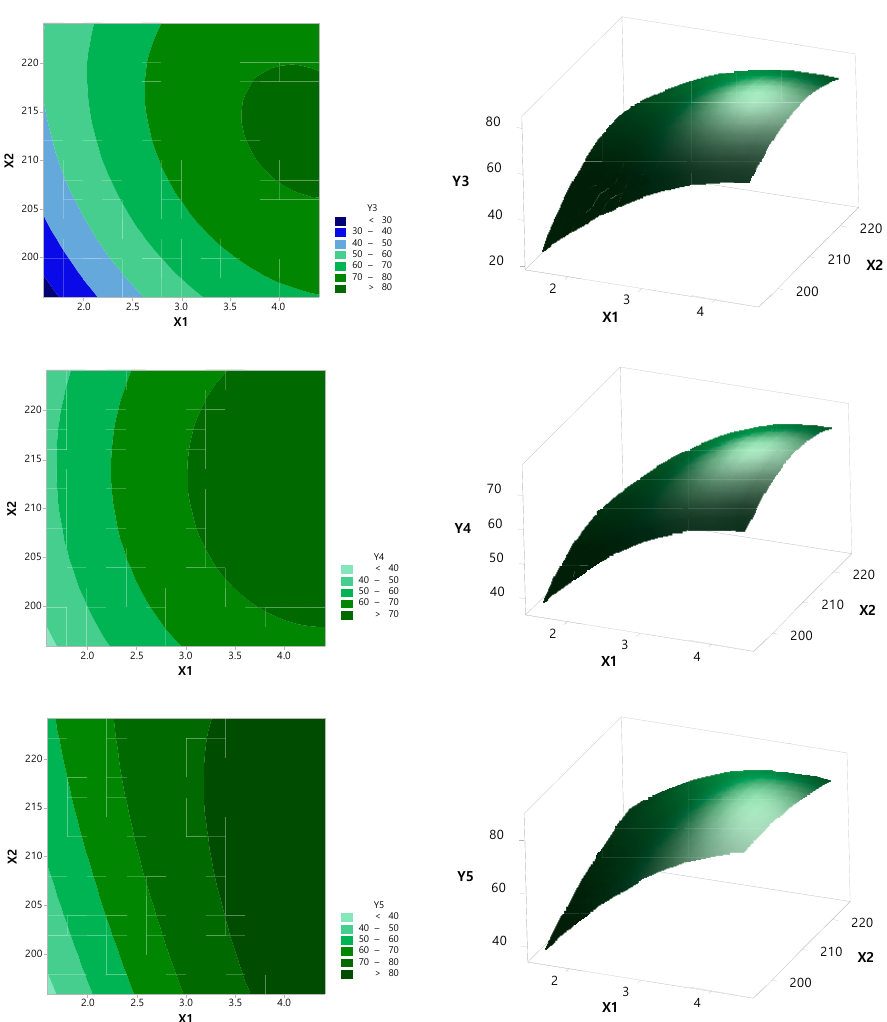
Figure 3. Contour and 3D response surface plot of dependent variables against independent variables: X1, PVP VA64 ratio; X2, barrel temperature (°C); Y1, content (%); Y2, dissolution rate (%) in SGF (2 h); Y3, dissolution rate (%) in SGF (6 h); Y4, dissolution rate (%) in SIF (2 h); Y5, dissolution rate (%) in SIF (6 h).